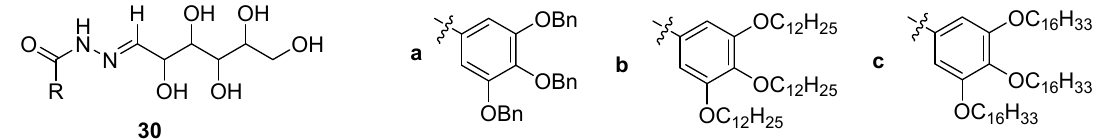
Figure 21. Structure of poly aryl ether glucose cored dendron-based LMWGs [64].